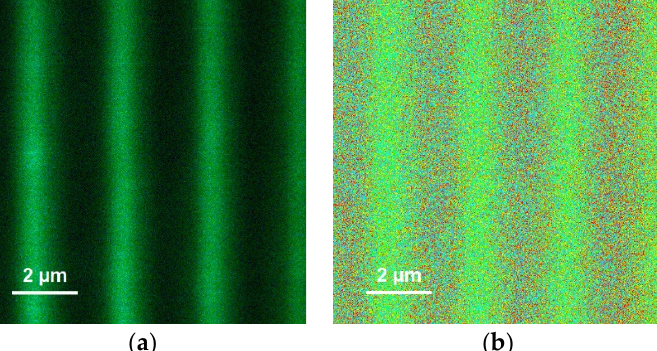
Figure 9. PL intensity image ( a ) and fluorescence lifetime image ( b ) of a grating with QDs. The excitation wavelength was 409 nm and the acquisition wavelength was 580 nm near the maximum of the QDs’ PL.